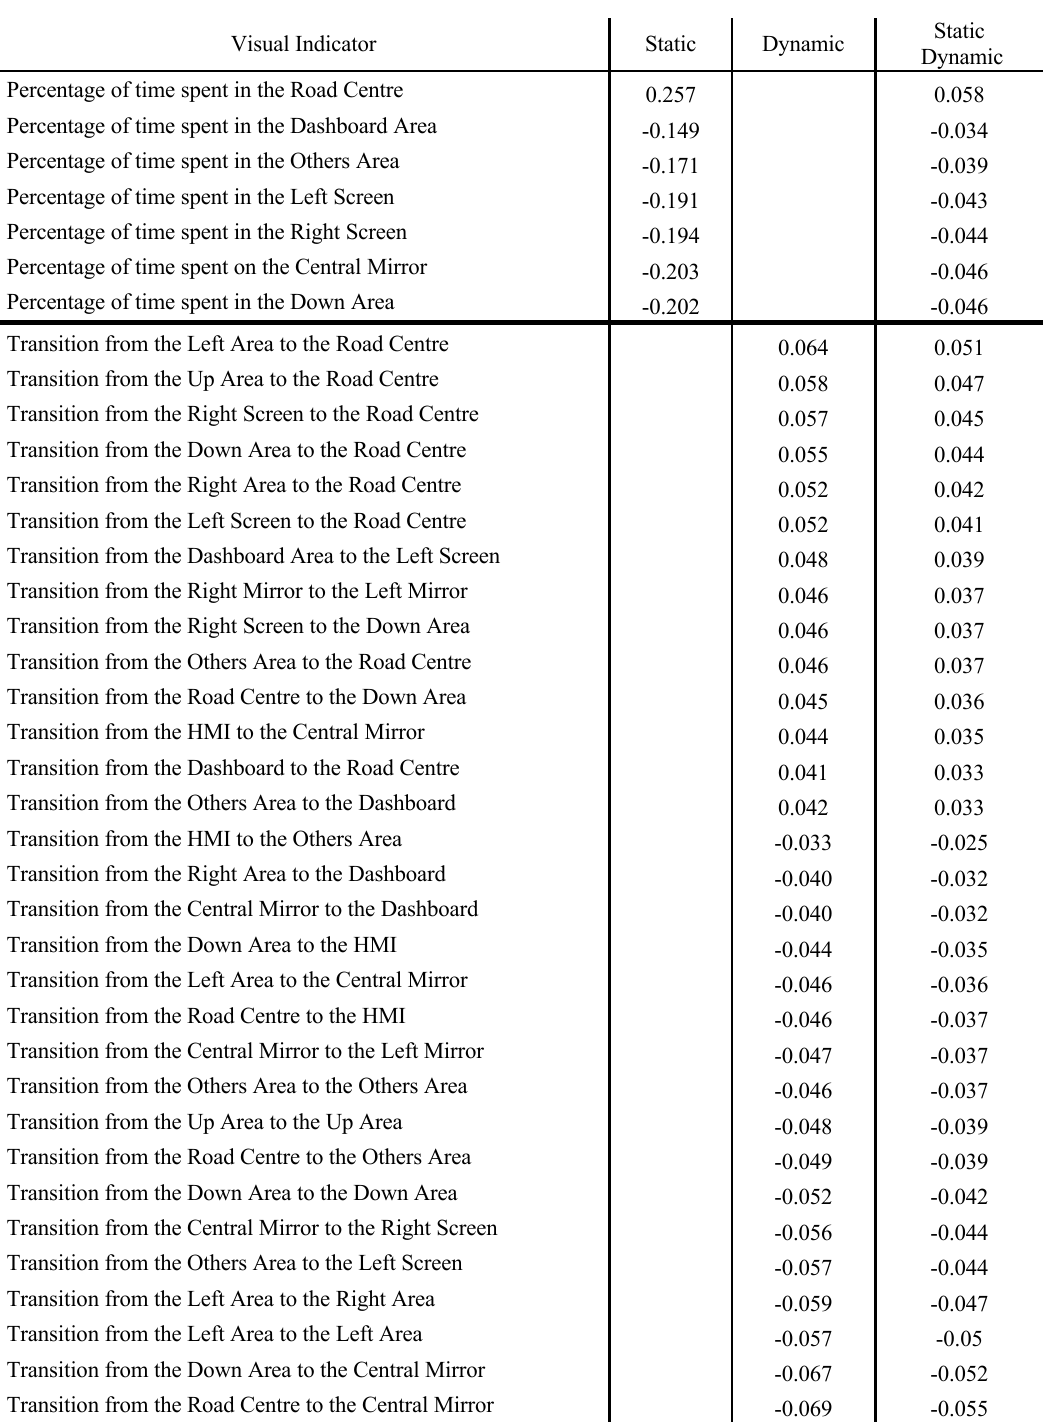
Table 2: PLS regression coefficients per visual indicator. A positive coefficient corresponds to a visual indicator characteristic of manual driving. A negative coefficient is associated with automated driving Static Visual Indicator Static Dynamic Dynamic Percentage of time spent in the Road Centre 0.257 0.058 Percentage of time spent in the Dashboard Area -0.149 -0.034 Percentage of time spent in the Others Area -0.171 -0.039 Percentage of time spent in the Left Screen -0.191 -0.043 Percentage of time spent in the Right Screen -0.194 -0.044 -0.203